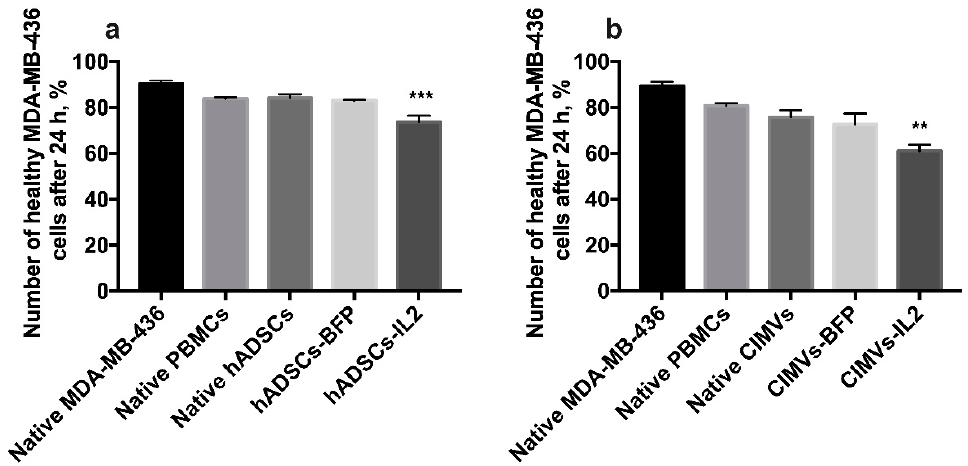
Figure 9. The cytotoxicity of activated PBMCs was also assessed in MDA-MB-436 cells. The cultivation of MDA-MB-436 cells with hADSCs-IL2-activated PBMCs resulted in the decrease of healthy (non-apoptotic and non-necrotic) cancer cells by 17% ( a ). The number of healthy MDA-MB-436 cells after 24 h of cultivation with PBMCs activated by CIMVs-IL2 was also reduced by 28% ( b ). Each box represents the mean ± SD ( n = 4) of four biological replicates. ** p < 0.01, *** p < 0.001. To analyze the effect of CIMVs-IL2 in in vivo, CD-1 immunocompetent mice were intravenously injected with 50 µ g (in 200 µ L of PBS) of native CIMVs, CIMVs-BFP or CIMVs-IL2. After 72 h, peripheral blood was collected and murine peripheral blood mononuclear cells were isolated and stained with antibodies typical for murine immune cell populations. There was no statistically significant difference in the number of murine CD45 + CD3 + CD4 − CD8 + T-cells after cultivation with CIMVs-IL2 (number of CD8 + T-cells after treatment with PBS only 13.71 ± 2.99%, native CIMVs 11.47 ± 2.94%, CIMVs-BFP 11.85 ± 3.30%, and CIMVs-IL2 12.56 ± 1.69%) (Figure 10a). Cultivation with CIMVs also failed to affect the number of CD45 + CD3 + CD8 − CD4 + T-cells (PBS only 28.98 ± 11.31%, native CIMVs 23.17 ± 5.58%, CIMVs-BFP 21.65 ± 4.39%, and CIMVs-IL2 29.6 ± 2.79%) (Figure 10b).